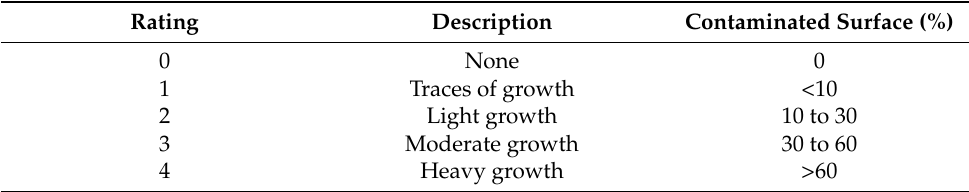
Table 3. Rate of mould growth adapted from ASTM D5590-17